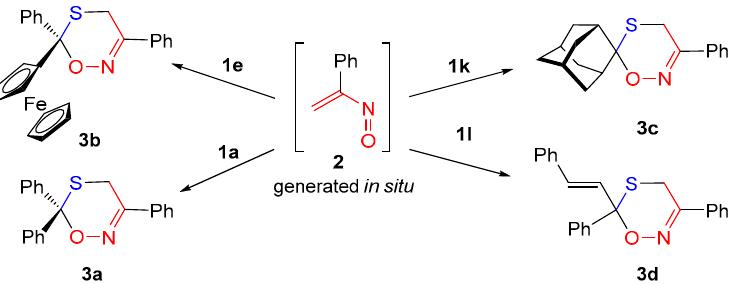
Figure 1. Synthetically useful representatives of aromatic 1a–d ; ferrocenyl 1e–h ; cycloaliphatic 1i–k ; and α , β -unsaturated 1l thioketones.